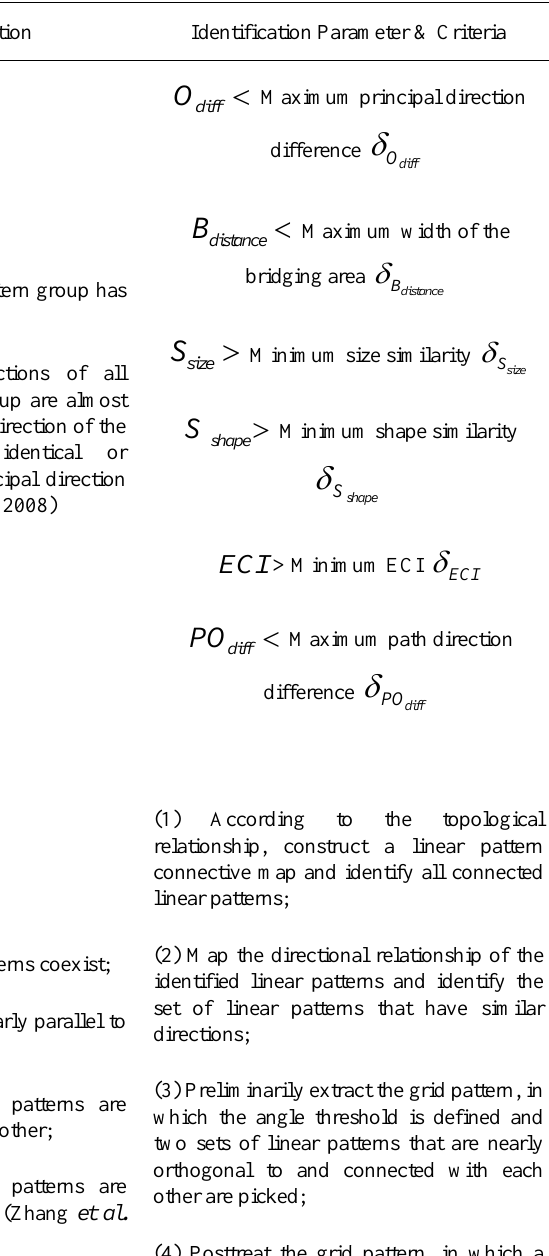
Table 1. Controlling parameters for the identification of structural characteristics of structured geographic